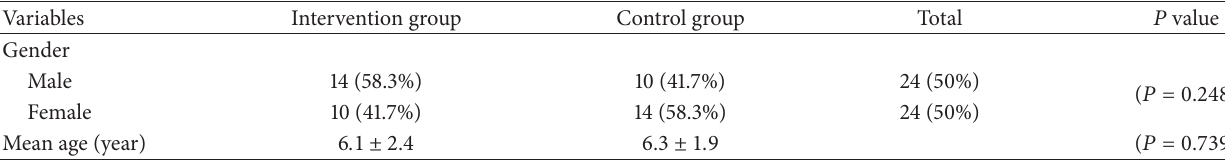
Table 1: Demographic characteristics of